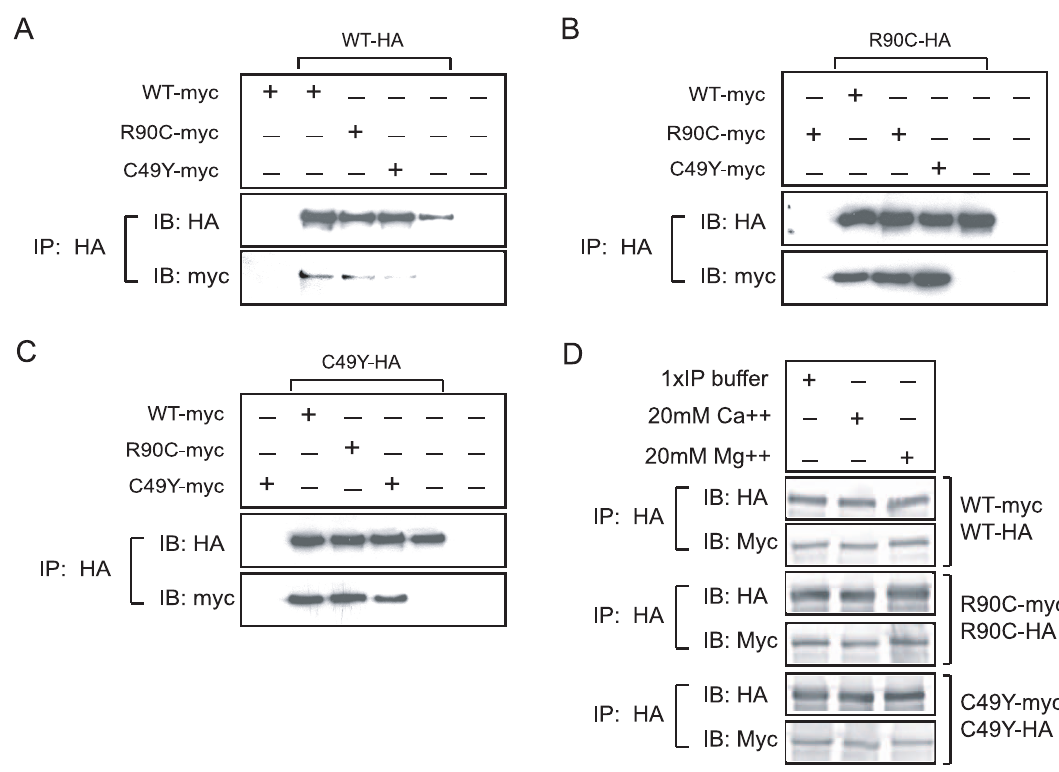
Figure 2. Interactions between wild-type and R90C and C49Y mutants of NOTCH3. (A–C) NOTCH3-NOTCH3 self-association is mediated by the extracellular domain. 293 cells were transiently co-transfected with cDNAs expressing the NOTCH3 extracellular domain tagged with HA (A, B, and C were transfected with WT, R90C, and C49Y, respectively) and cotransfected with myc tagged NOTCH3 ectodomain constructs as shown. The proteins were extracted after 40 , 48 hours and immunoprecipitated with HA monoclonal antibody. Co-immunoprecipitates of cells cotransfected with plasmid combinations shown were analyzed by immunoblotting (IB). Quantification of protein bands from four independent experiments failed to show a significant difference in IP complexes with any of the NOTCH3 combinations. (D) Effect of divalent cations on stability of NOTCH3 homophilic interactions and the stability of NOTCH3 homophilic complexes. Coimmunoprecipitation was performed using the HA antibody on lysates of cells transfected with plasmid combinations shown on the right column. Immunoprecipitates were washed extensively with buffers containing calcium or magnesium, and then analyzed by western blotting. All of the HA and myc tagged proteins run on SDS gels at an apparent molecular weight of 175 kDa. We verified the finding of numerous groups that common epitope tags do not mediate protein interaction [64,65,66] (not shown). All experiments were performed more than 6 times.